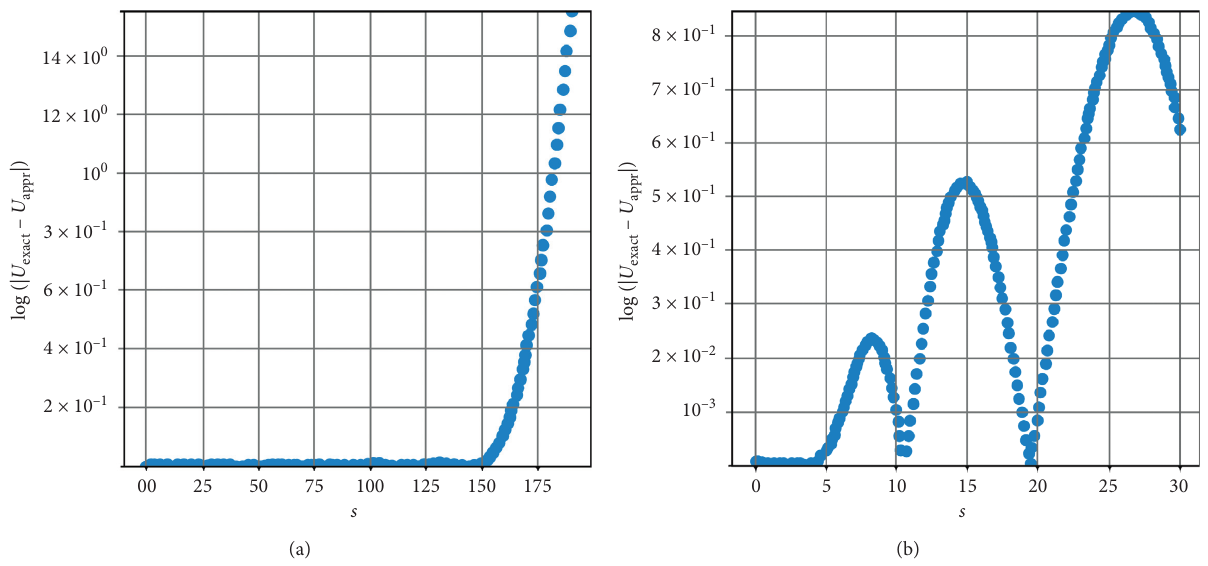
Figure 3: Plots of the logarithmic absolute error for the solution of Example 1 when the number of hidden neurons is 20 and d t � 1/20, the logarithmic error (a) using the truncating approach and (b) using the mapping function.